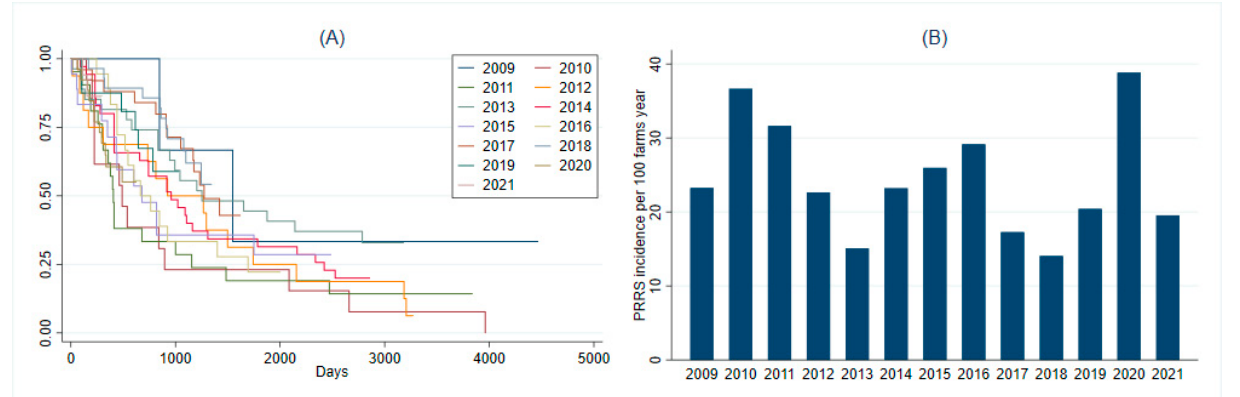
Figure 1. Kaplan–Meier curve on the probability of not having a PRRS outbreak according to the year the naïve status was achieved ( A ) and the PRRS incidence rate per 100 farm years by year in which sites became naïve ( B ).